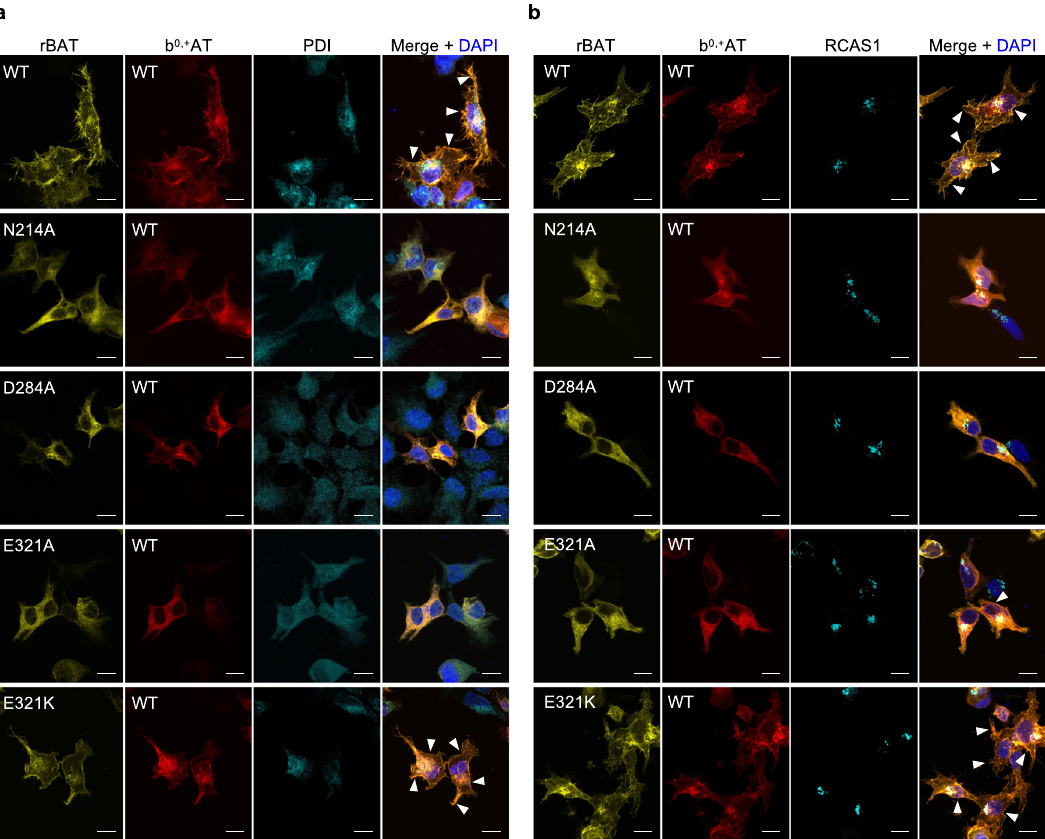
Fig. 7 Localization of b 0, + AT-rBAT and its Ca 2 + -binding site mutants. Fluorescence imaging of HeLa cells expressing wild-type b 0, + AT-mCherry (red) and wild-type or mutated GFP-rBAT (yellow). Fluorescent staining with anti-PDI (panel a , colored cyan) and anti-RCAS1 (panel b , colored cyan) antibodies were used as markers for the ER and Golgi apparatus, respectively. Plasma membrane localization of b 0, + AT-rBAT are indicated in the white arrowheads. Scale bar = 10 μ maturation (Fig. 8b: lane 4) and low transport function (Fig. 8d).